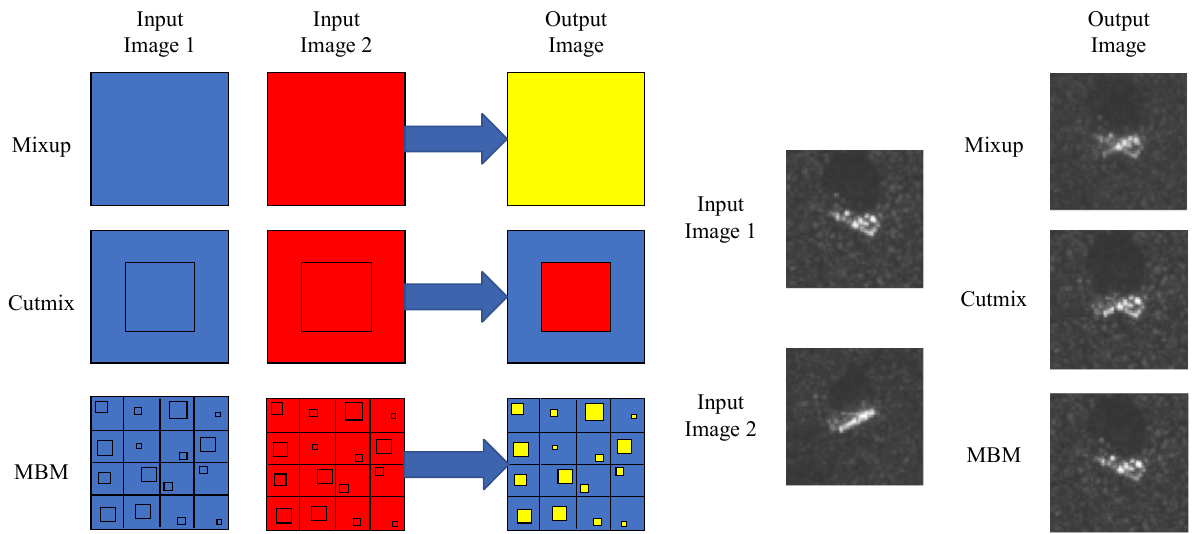
Figure 2. Overview of mixup, cutmix, and our multi-block mixed (MBM) blending methods. The left part of the figure is an example of the operation of the three hybrid methods. Among them, the mixup method performs interpolation operations on the input image; the cutmix method introduces an additional matrix M (omitted in the figure) and uses element-wise multiplication to replace part of the content in the input image; the MBM method divides the picture into N parts and selects a small part of each part and the corresponding part of another input image for interpolation and mixing. The input SAR images of the three methods and the new samples generated are shown on the right side of the figure, and the generation method does not strictly correspond to the frame selection position in the left